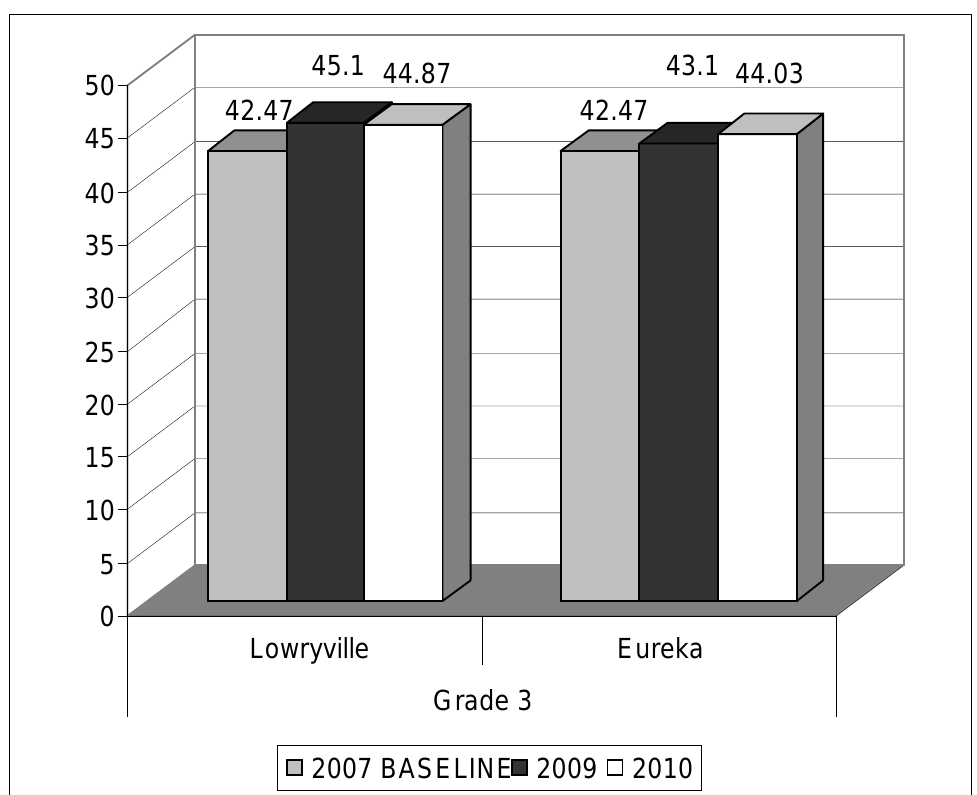
Figure 9 Boehm- R test Scores of Grade 3 Learners in 2007, 2009 and